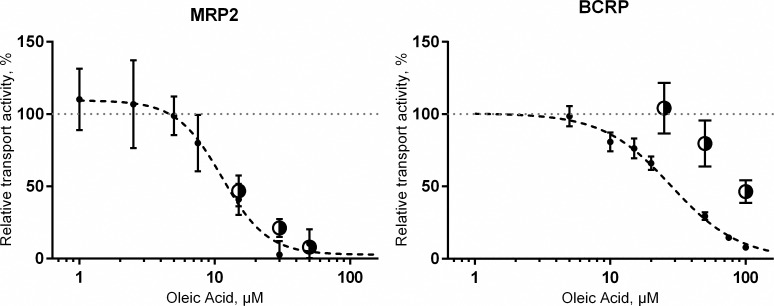
Inhibition of 5 μM CDCF uptake into MRP2 vesicles and 50 μM LY uptake into BCRP vesicles by oleic acid.Data is presented as a relative transport activity normalized to uptake in the absence of oleic acid. Small, closed circles show results from inhibition studies and larger black/white circles represent the retention of CDCF or LY in vesicles in studies on unspecific membrane effects of oleic acid (for details see Materials and Methods). All data points were assayed in triplicate and curve fitting was performed using the four parameter logistic equation. Graphs show the results from a representative experiment and data is represented as mean ± SD. IC50 (95% confidence interval) for BCRP was 28.2 μM (21.7–37.7). In the case of MRP2, the IC50 was not applicable.